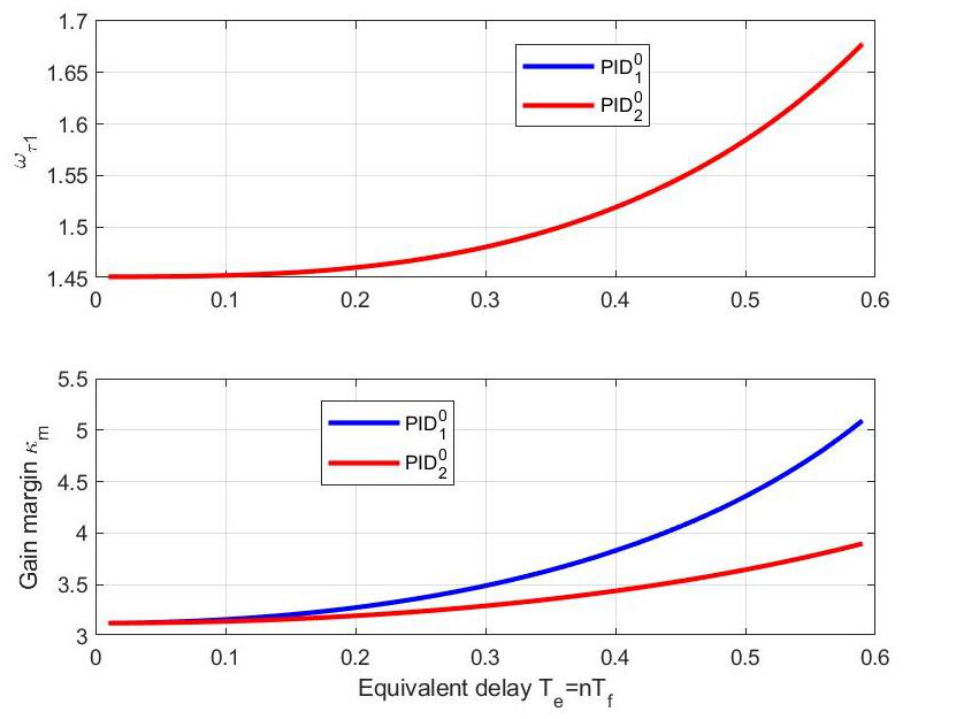
Figure 2. Calculating the gain margin κ m of the filtered PID 0 the T f = T e / n tuning equivalence, n = 1,2.